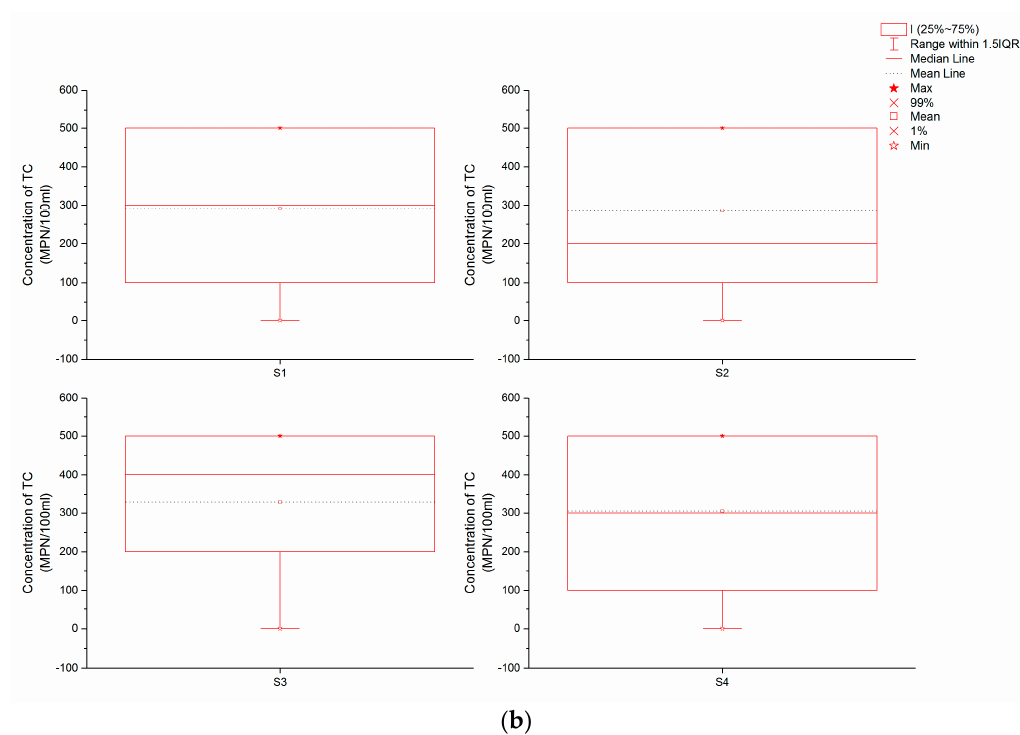
Figure 2. Results from sampling sites. ( a ) TB concentrations; ( b ) TC concentrations.